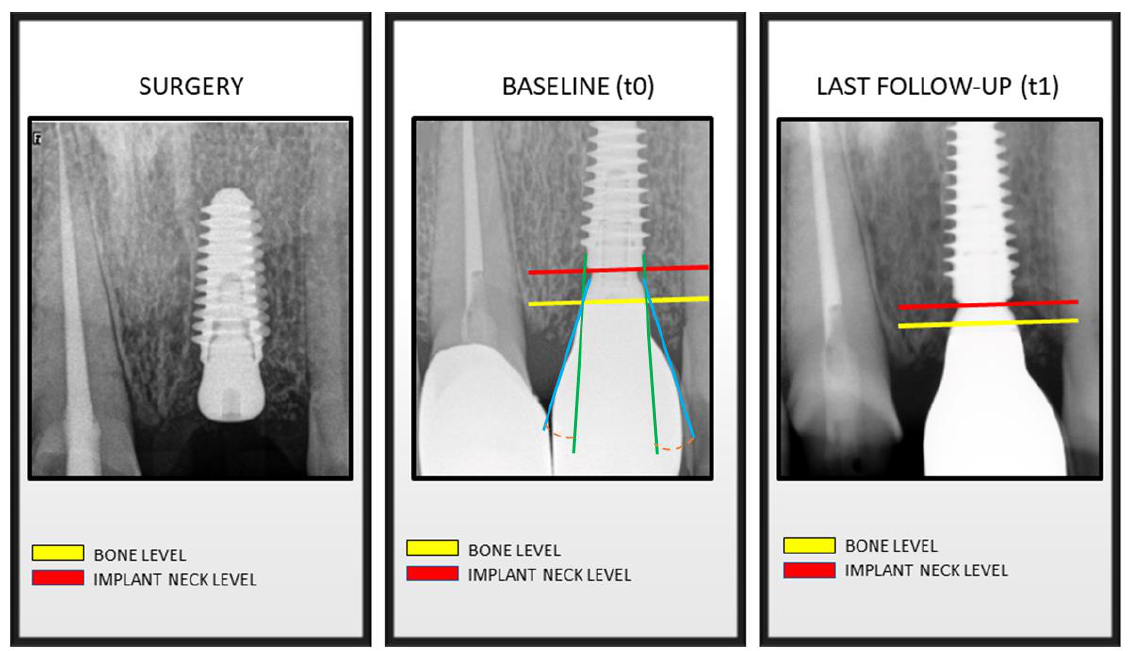
Figure 3. Bone levels at time of implant surgery, at prosthesis installation (baseline) and at last follow-up visit. Green line: implant axis. Blue line: prosthetic emergence profile axis. Orange line: angle between implant axis and prosthetic emergence profile ≤30°, determining the allocation in Group 2.